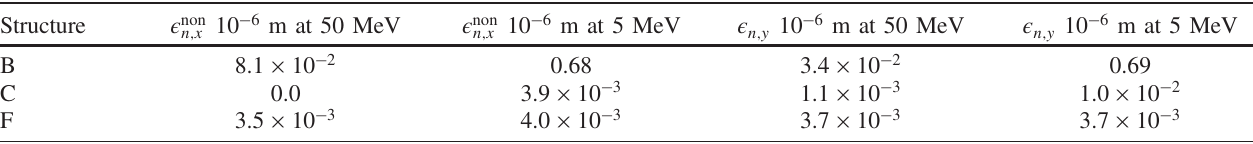
TABLE III. Comparison of induced emittance growth at 50 MeV and at 5 MeV beam energy. The rms beam size is 1 mm; in the streaking x direction the linear emittance contribution has been quadratically subtracted. Structure